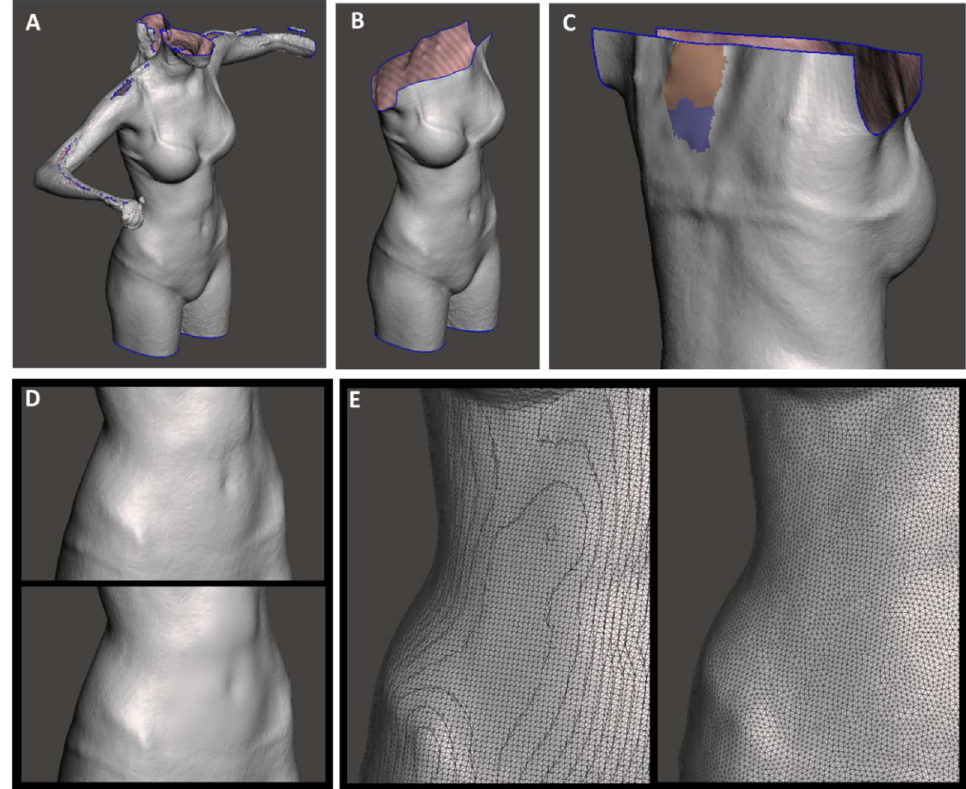
Figure 2. Preprocessing phases: ( A ) raw scan; ( B ) removal of unnecessary body parts; ( C ) closing holes in the mesh; ( D ) local smoothing without re-mesh; ( E ) zoom on the right side before (left) and after (right) global re-mesh.